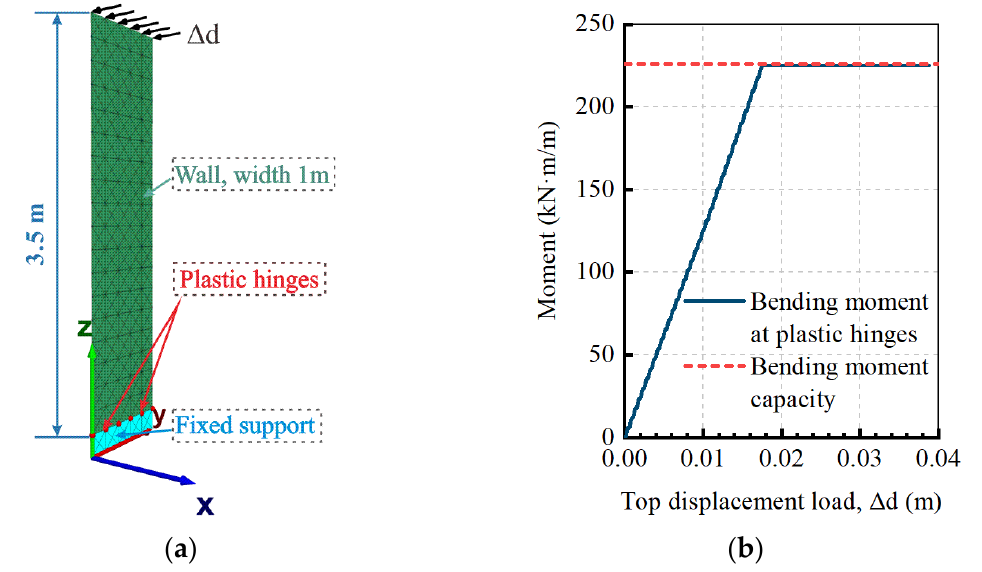
Figure 4. ( a ) Wall with plastic hinges at members’ joint, and ( b ) bending moment at the plastic hinge under horizontal displacement load.